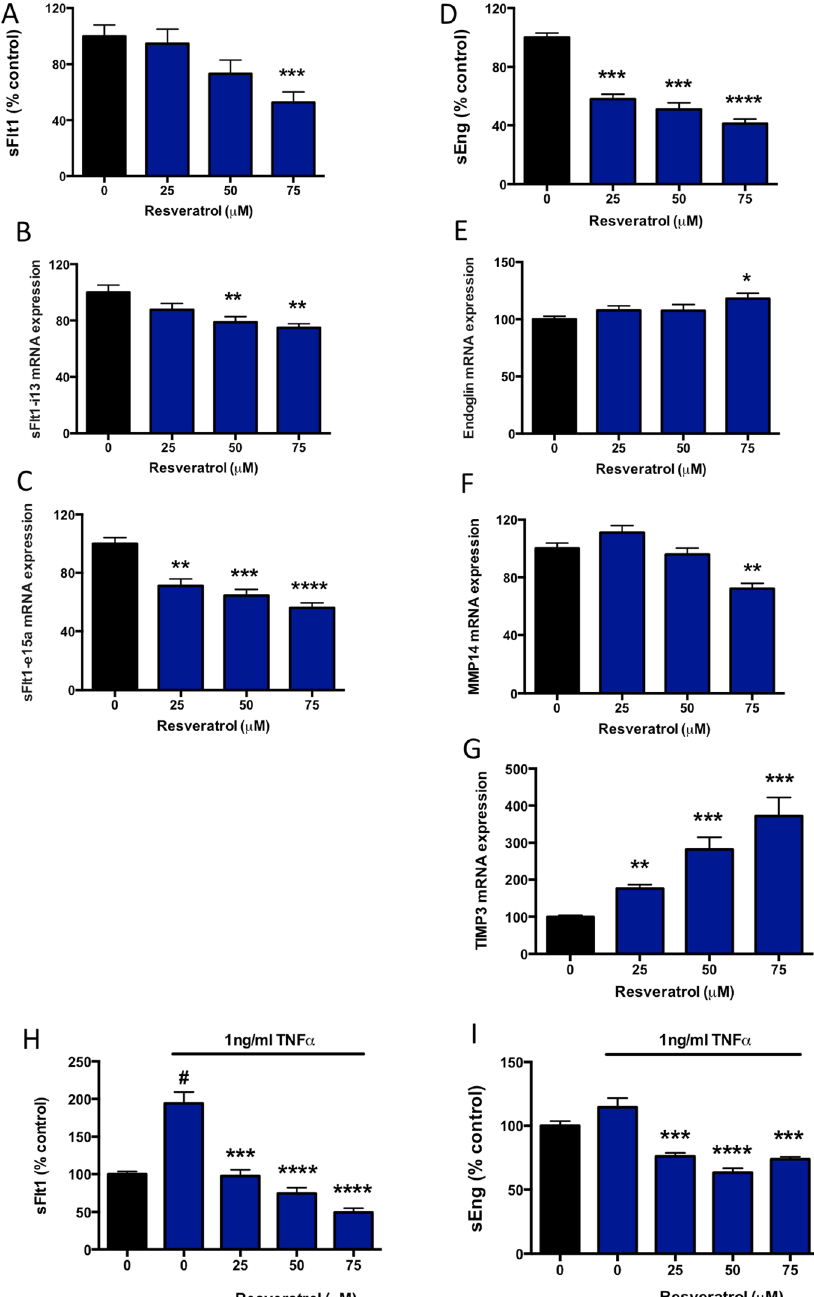
Figure 2. Resveratrol significantly reduces sFlt1 and sEng secretion from primary HUVECs. Resveratrol was added at increasing doses to primary HUVECs under basal conditions ( A–G ) or after addition of TNF α (H,I), and the effect on sFlt-1 and sEng secretion was determined. ( A ) Resveratrol induced a significant reduction in sFlt-1 secretion at 75 μ M. This was accompanied by a ( B ) significant reduction in sFlt-1 ei13 mRNA expression and a ( C ) significant reduction in sFlt-1 e15a mRNA expression. We also found that resveratrol significantly reduced sEng secretion from primary HUVECs ( D ). This was accompanied by significantly increased endoglin ( E ), mRNA expression. ( F ) In primary HUVECs, resveratrol significantly reduced MMP14 expression whilst ( G ) upregulating expression of its natural inhibitor TIMP3. We also assessed the effect of resveratrol in the presence of TNF α ( H,I ). TNF α significantly increased sFlt-1 secretion, and this effect was reversed by treatment with resveratrol ( H ). In contrast TNF α did not significantly alter sEng secretion, however resveratrol still significantly reduced secretion in the presence of TNF α ( I ). Data expressed as mean ± SEM. For A–G , * p < 0.05 ** p < 0.01, *** p < 0.001, **** p < 0.0001. For H,I , # p < 0.05 compared to control, *** p < 0.001, **** p < 0.0001 compared to TNF α alone. N = 3–5 experimental replicates, with each n taken from a separate patient